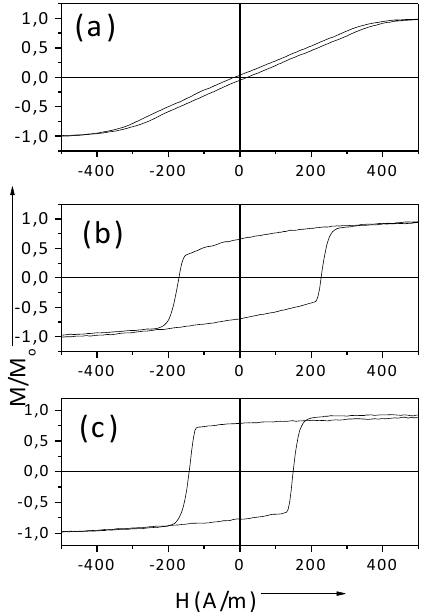
Fe Ni B Si 50.69 8.13 17.55 13.29 10.34